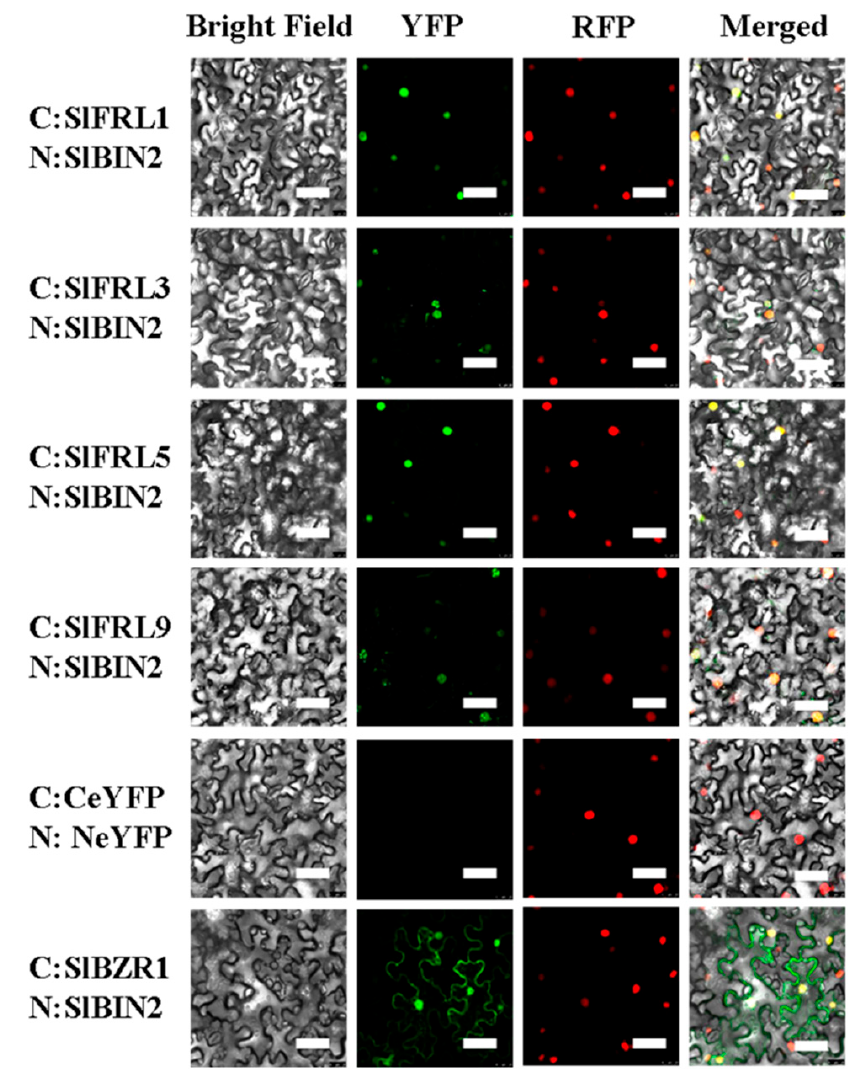
Figure 3. SlFRLs physically interact with SlBIN2 in mesophyll cells of tobacco (BiFC analysis). YFP is a yellow fluorescent protein; RFP is a red fluorescent protein; bar = 50 μ m.